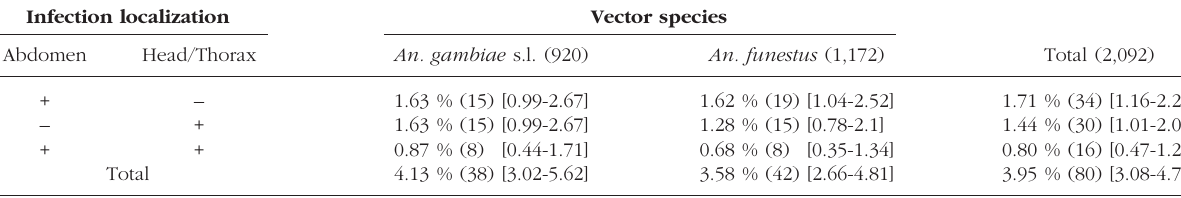
Table I. – P. falciparum CSP antigen prevalences in malaria vectors for the whole study period. ( ) = number of specimens tested (head of column) and positive (table). [ ] = 95 %